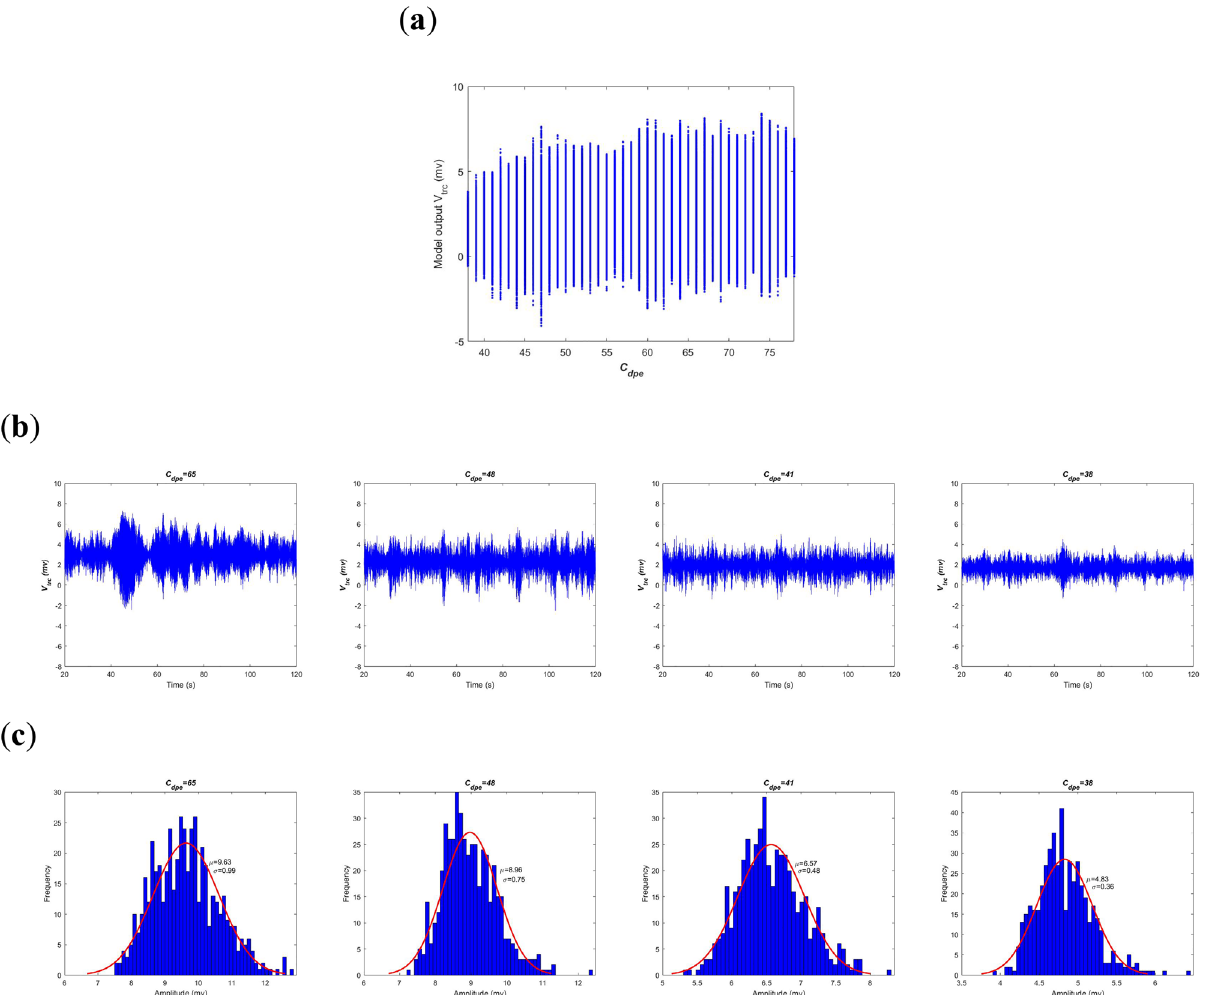
Figure 7. Amplitude analysis of the BTC model output V t in time domain when the excitatory synapse connectivity parameter C dpe from PY to PNN is varied in the range of[38,78]. ( a ) The model output of the summated postsynaptic potential V t for each C dpe . ( b ) The summated postsynaptic potential V t during[20, 120] s when C dpe takes some values of 38, 41, 48, and 65. ( c ) Amplitude distribution of V t based on 500 simulation results when C dpe takes some values of 38, 41, 48, and